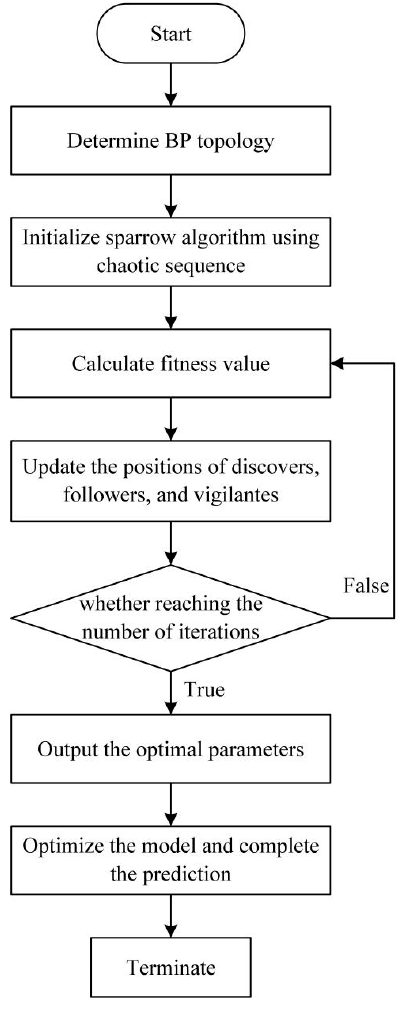
Figure 8. The fl ow chart of the chaotic sparrow algorithm. Figure 8. The flow chart of the chaotic sparrow The steps of the chaotic sparrow algorithm are listed below.